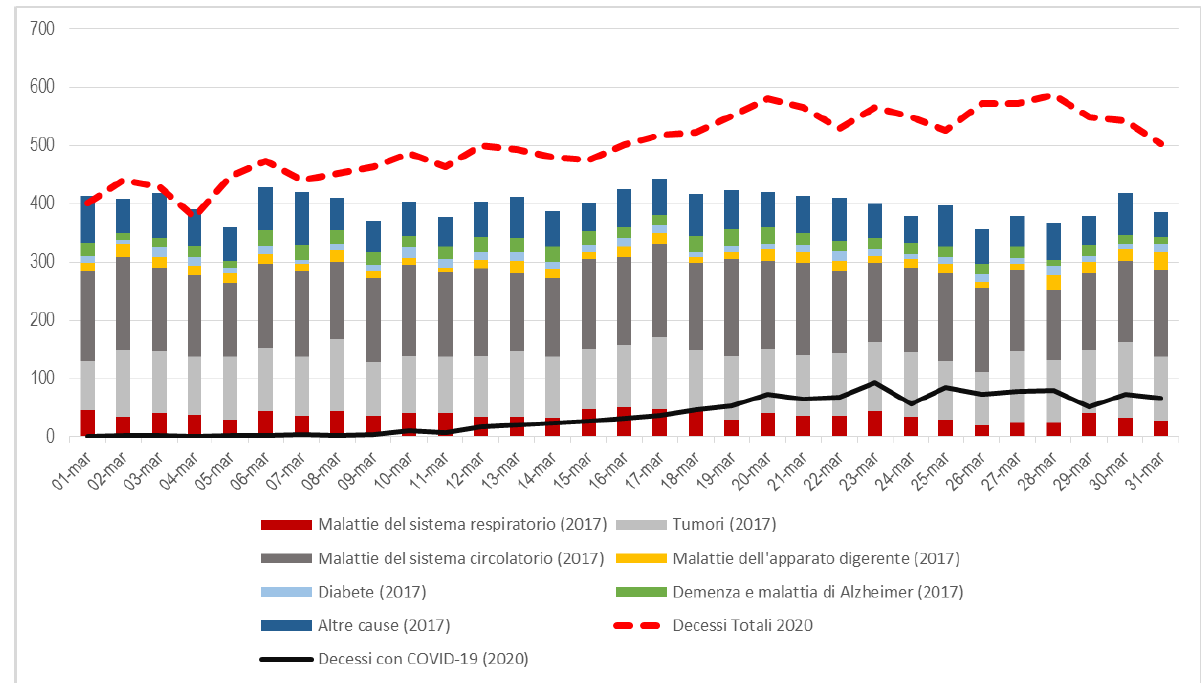
Figura 15 . Confronto tra i decessi giornalieri per le principali cause iniziali di morte a marzo 2017 e i decessi con Covid-19 e per tutte le cause a marzo 2020. Area livello